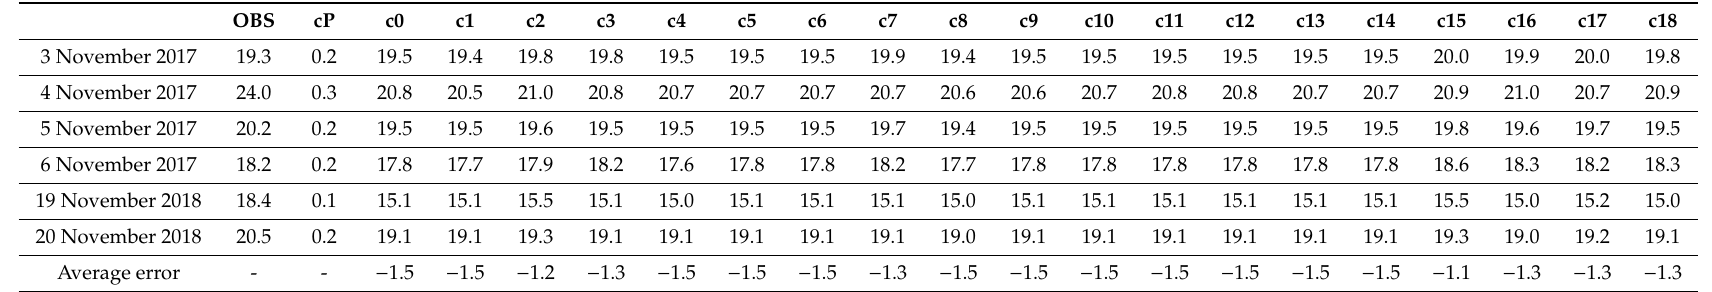
Table 4. Daily maximum T2m values ( ◦ C) at the CIRA site for the days considered, for observational and model data (all configurations). Average cumulative errors with respect to observations. Maximum deviation (cP) from the reference simulation with the initial condition